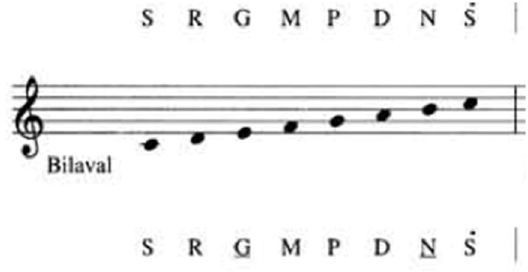
Figure 4. Sargam (music notation) of raga Bilawal.